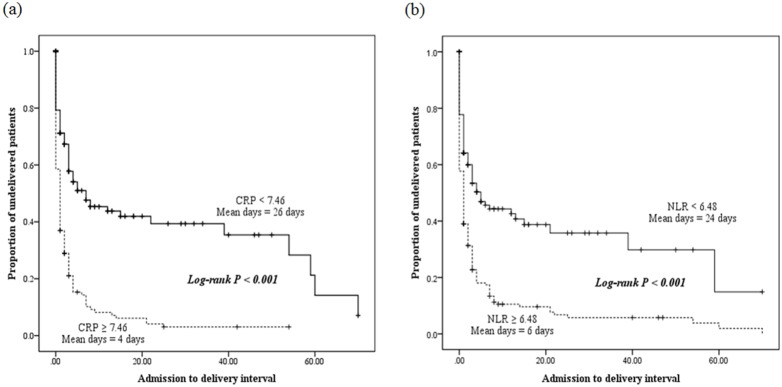
Kaplan-Meier overall survival of admission-to-delivery intervals according to C-reactive protein (CRP)(a) and neutrophil to lymphocyte ratio (NLR) (b). CRP-positive (≥7.46), NLR-positive (≥6.48), dotted line; CRP-negative (<7.46), NLR-negative (<6.48), broken line.